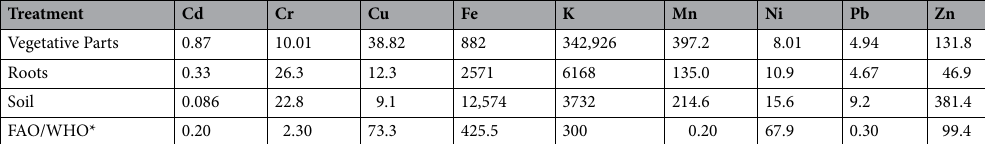
Table 11. Overall heavy metals averages for all treatments, [ppm]. Vegetative Parts = Shoots + Leaves. * = in vegetables.